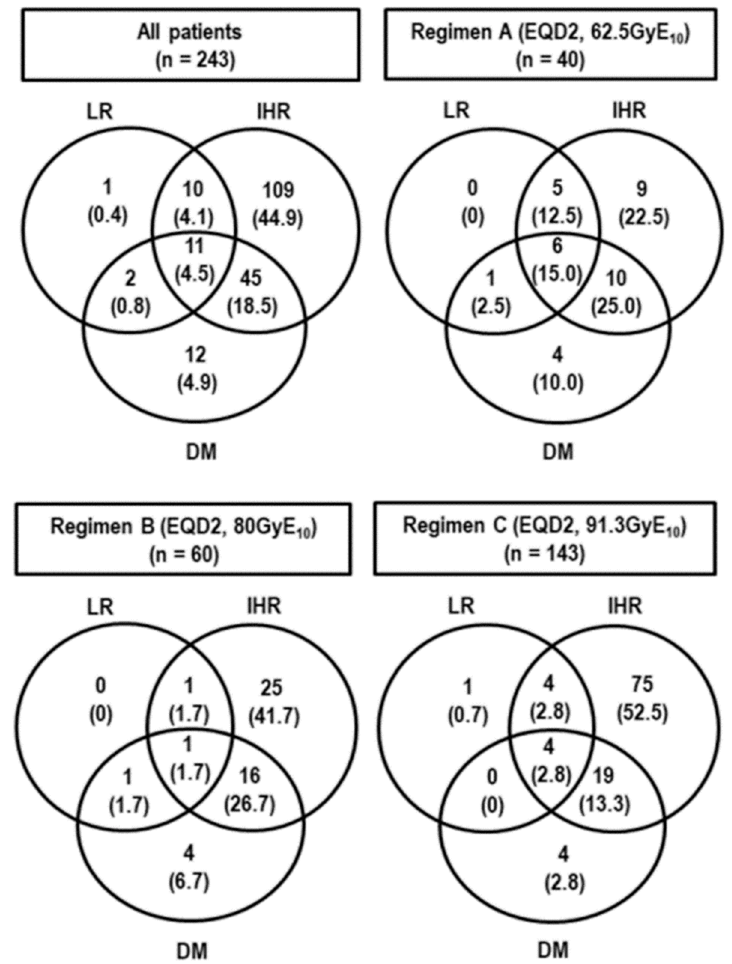
Figure 2. Patterns of failure. Abbreviations: LR, local recurrence; IHR, intrahepatic recurrence; DM, distant metastasis.